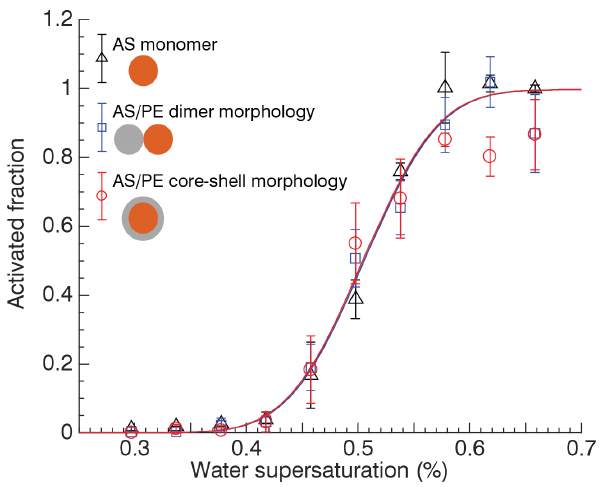
Figure 5. Activation properties of ammonium sulfate monomers and mixed ammonium sulfate / polyethylene particles with core- shell morphology with varying coating thickness. Error bars cor- respond to ± 1standard deviation associated with activated faction estimated from three separate